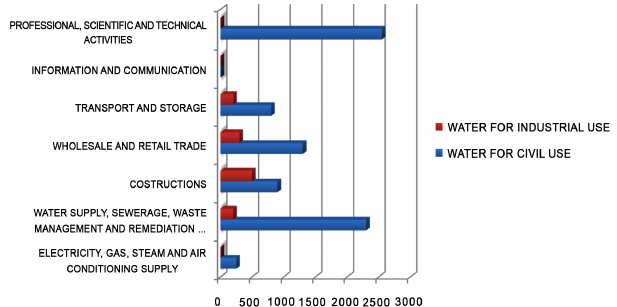
Figure 3. Water consumption for industrial and civil use by indus- trial sector [m 3 ] (Source: ARGAIP